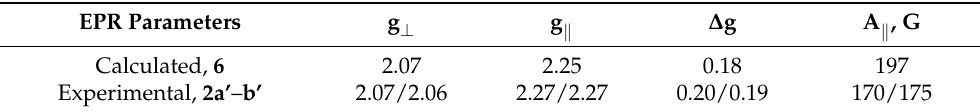
Figure 11. Top ( a ) and side ( b ) view of the optimized structure of the blue mononuclear complex 6 containing a mycaminosate moiety and a η 2 -nitrate anion ( B3LYP ) with structural parameters (underlined) and NBO charges. Colour code: C—grey, O—red, N—blue, Cu—magenta. Table 6. Calculated EPR characteristics of the mononuclear blue mycaminosate complex 6 in solid state.